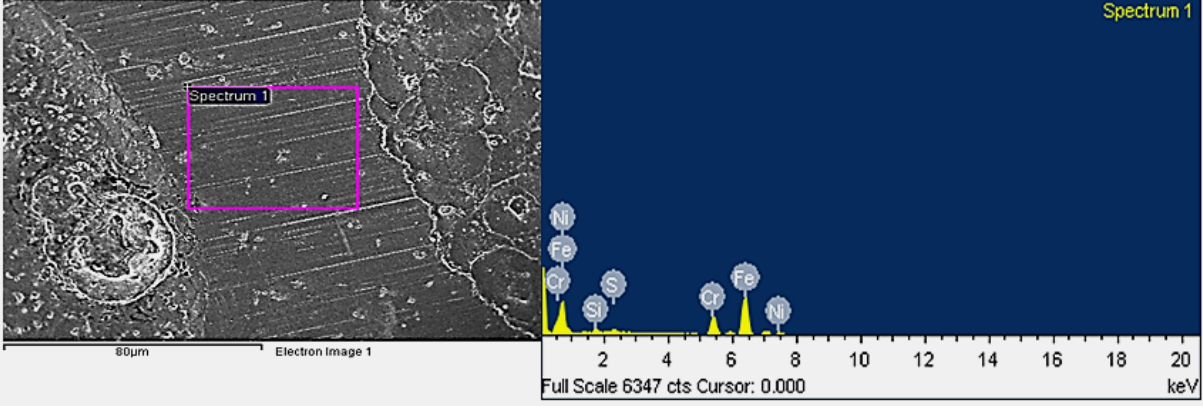
Figure 2. EDS spectra of SS316. Table 1. Chemical composition of Ti-6Al-4V. Table 3. Dimension and the thermo-physical properties of different work pieces.